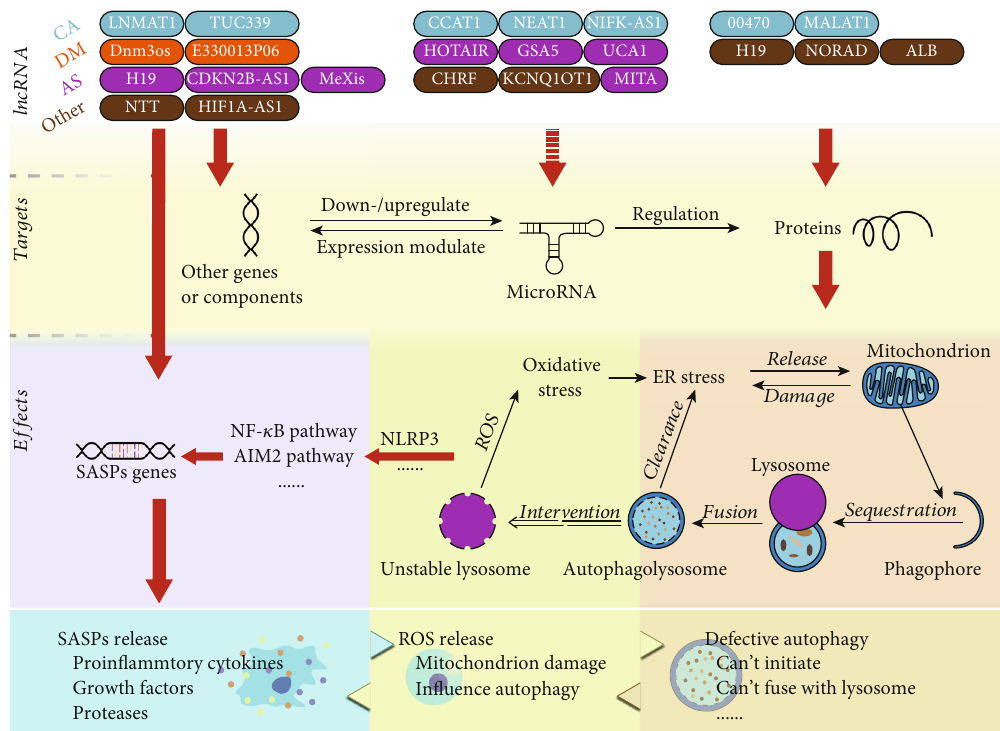
Figure 3: Schematic of the mechanism of how lncRNA triggers in fl ammaging and cellular senescence. CA: cancer; DM: diabetes mellitus; AS: